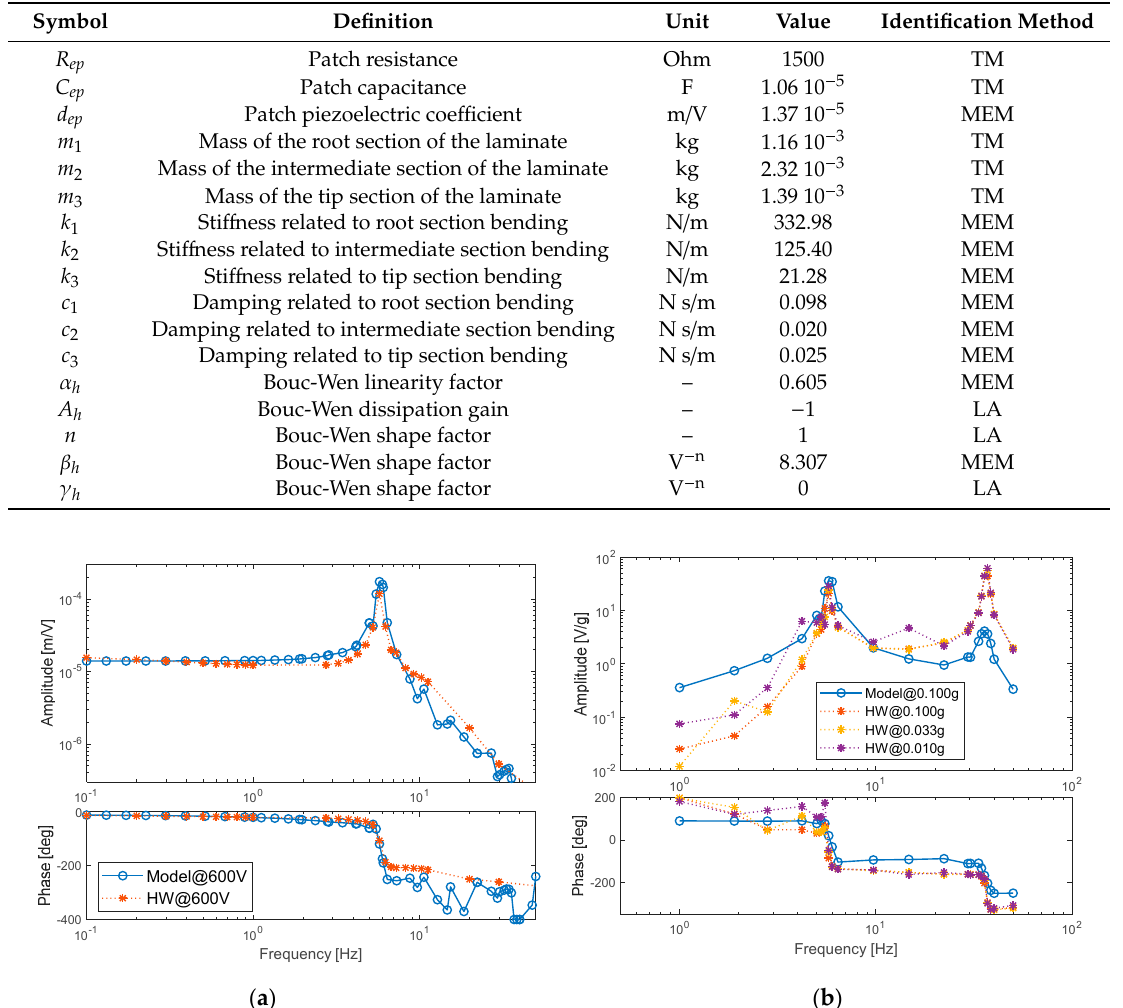
Table 2. Dynamic model parameters (identification method legend: TM, test measurement; MEM, model error minimization; LA: literature assumption from [54]).